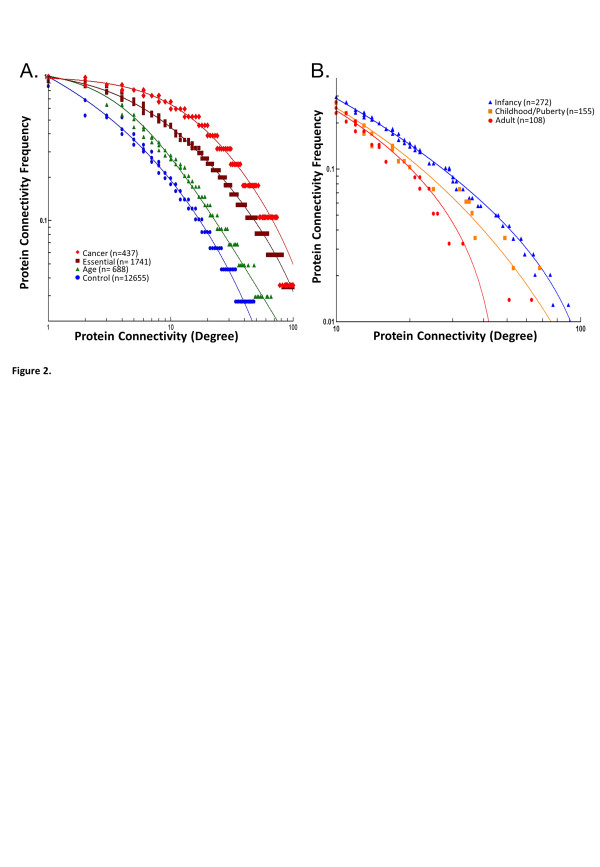
Analysis of protein connectivity (degree) in the human interactome as a measure of protein function. Protein connectivity was measured from a model of the human interactome (Biogrid build 3.1.87) and plotted against the frequency of proteins of specific degree; a right shift indicates an increase in connectivity and implies increased functional relevance [15,16]. A) Comparison of proteins with age related differences in expression [green marker n = 688] with genes associated with cancer (Cancer Gene Census database [25]) [red marker n = 437], “essential” genes derived from human orthologs of mouse lethal genes [26] [brown marker n = 1741] and control genes [16] [blue marker n = 12655]. All data sets are significantly different p < 0.0001, Wilcoxon test. B) Comparison of the connectivity within the human interactome proteins associated with gene expression changes during human growth; infancy, blue marker n = 272; Childhood/Puberty, orange marker n = 155; Adult/Final height, red marker n = 108. All data sets are significantly different p < 0.0001, Wilcoxon test.